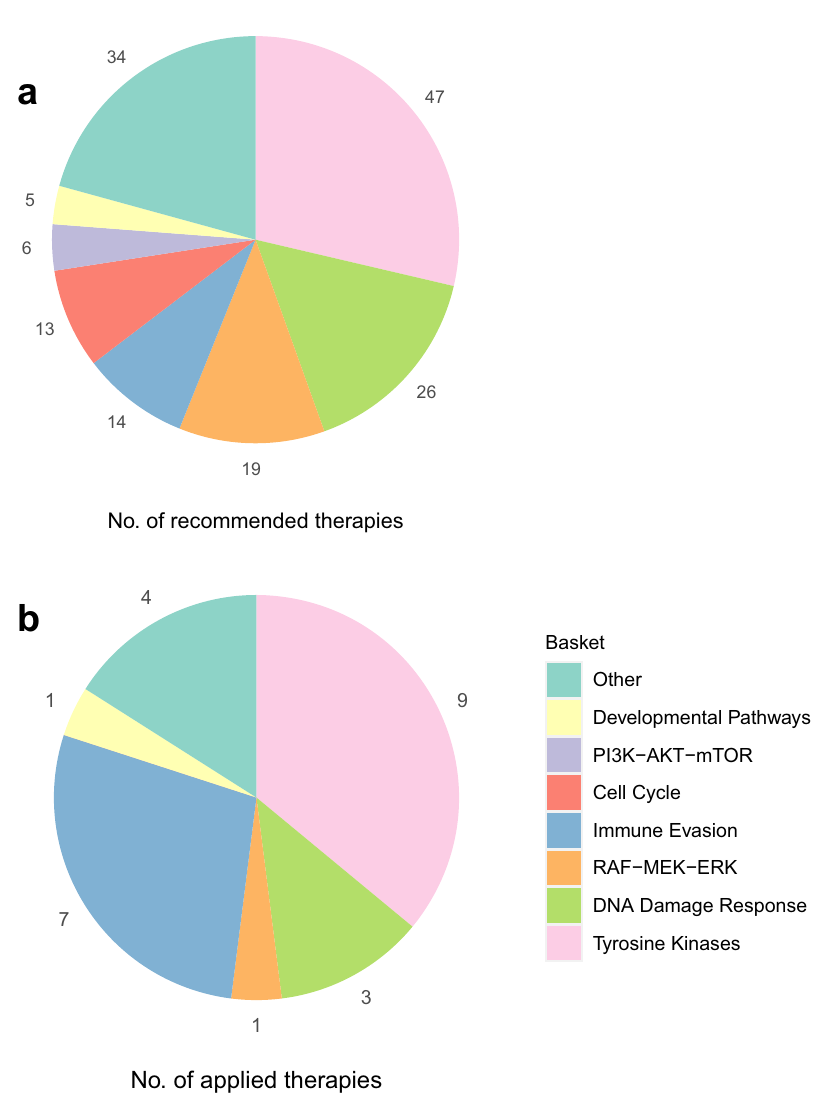
Fig. 4 Recommended and applied therapies. Distribution of all therapy recommendations among 8 different baskets. Please note that most patients received several recommendations. Distribution of a all therapy recommendations and b fi rst 20 clinically applied therapy recommendations among eight baskets: Tyrosine Kinases, DNA Damage Response, Immune Evasion, Cell Cycle, RAF-MEK-ERK, PI3K-AKT-mTOR, Developmental Pathways and Other. Combination therapies were sorted into multiple baskets based on their mechanism of action. Source data are provided as a Source Data fi